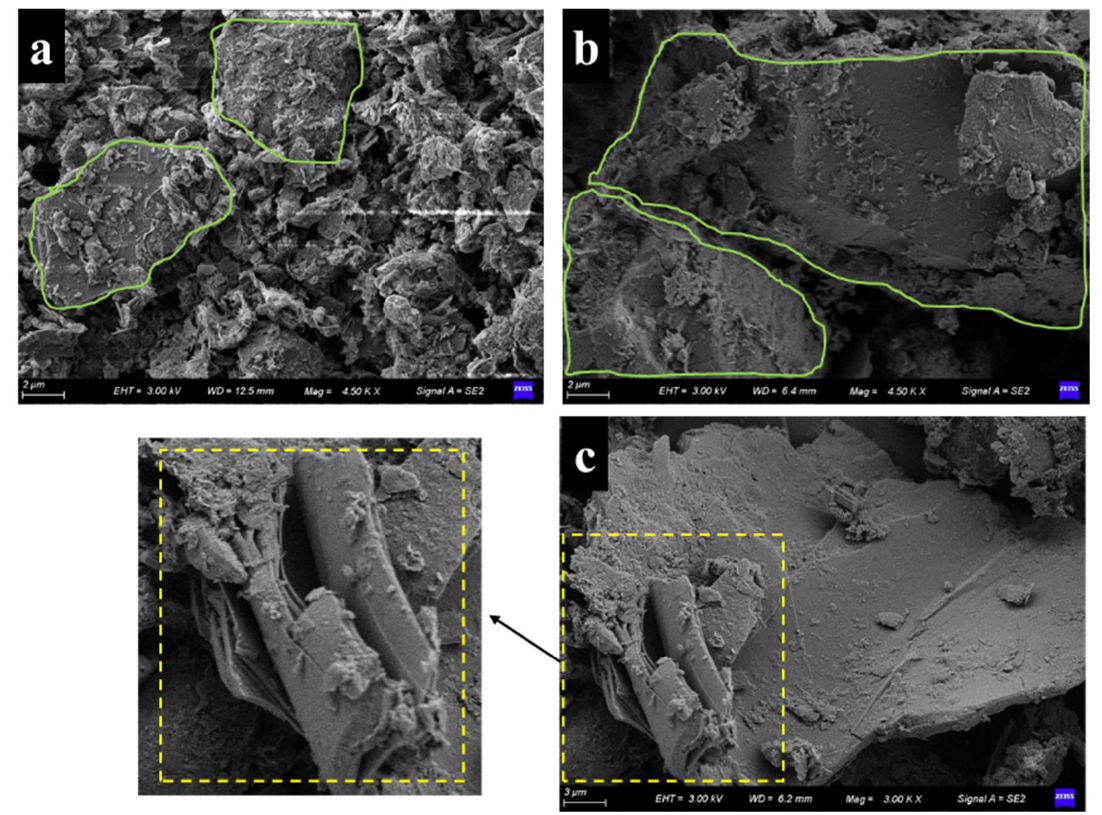
Figure 7. SEM test results of modified loess: ( a ) attapulgite-modified loess, ( b ) attapulgite-lime- modified loess, and ( c ) attapulgite-cement-modified loess.